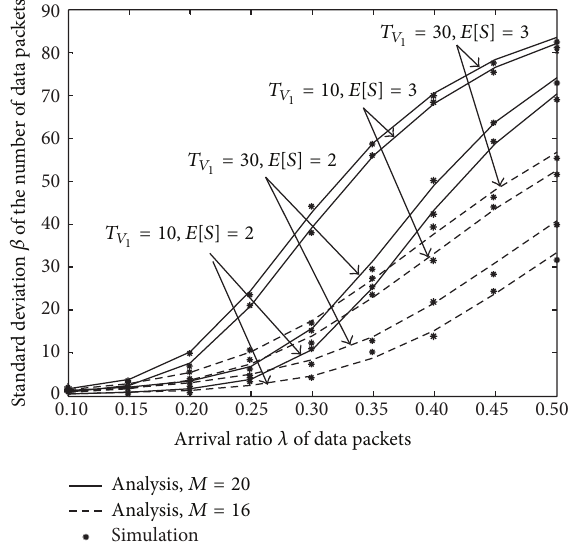
Figure 7: Standard deviation 𝛽 of the number of data packets versus arrival ratio 𝜆 of data